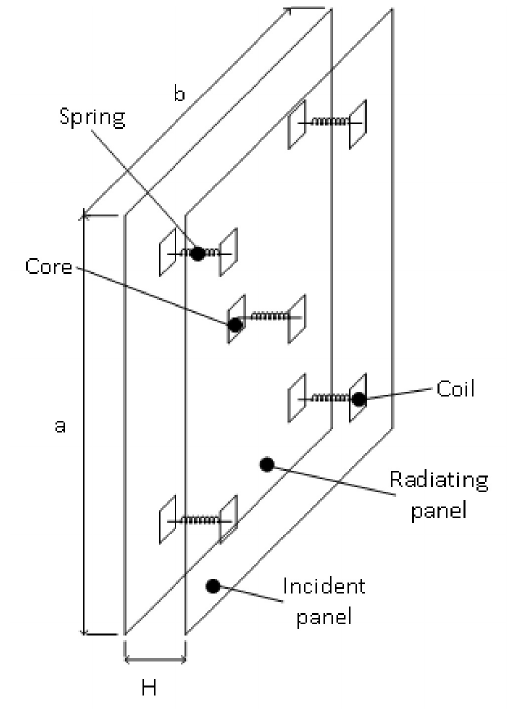
Figure 1. Scheme of double panel structure under mass-spring-mass vibro-acoustic